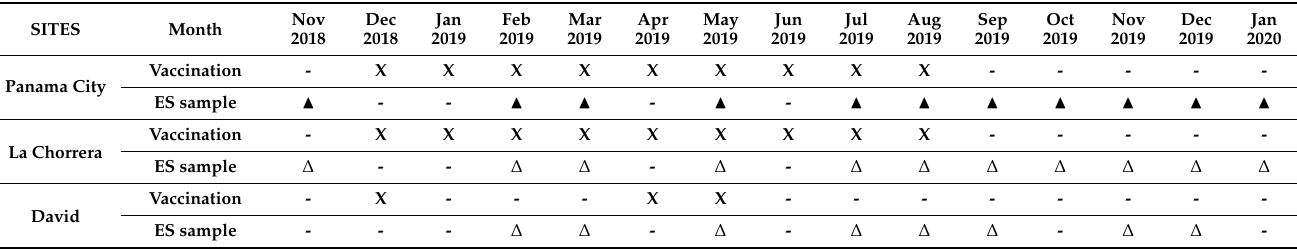
Table 2. Timing for vaccination and sample